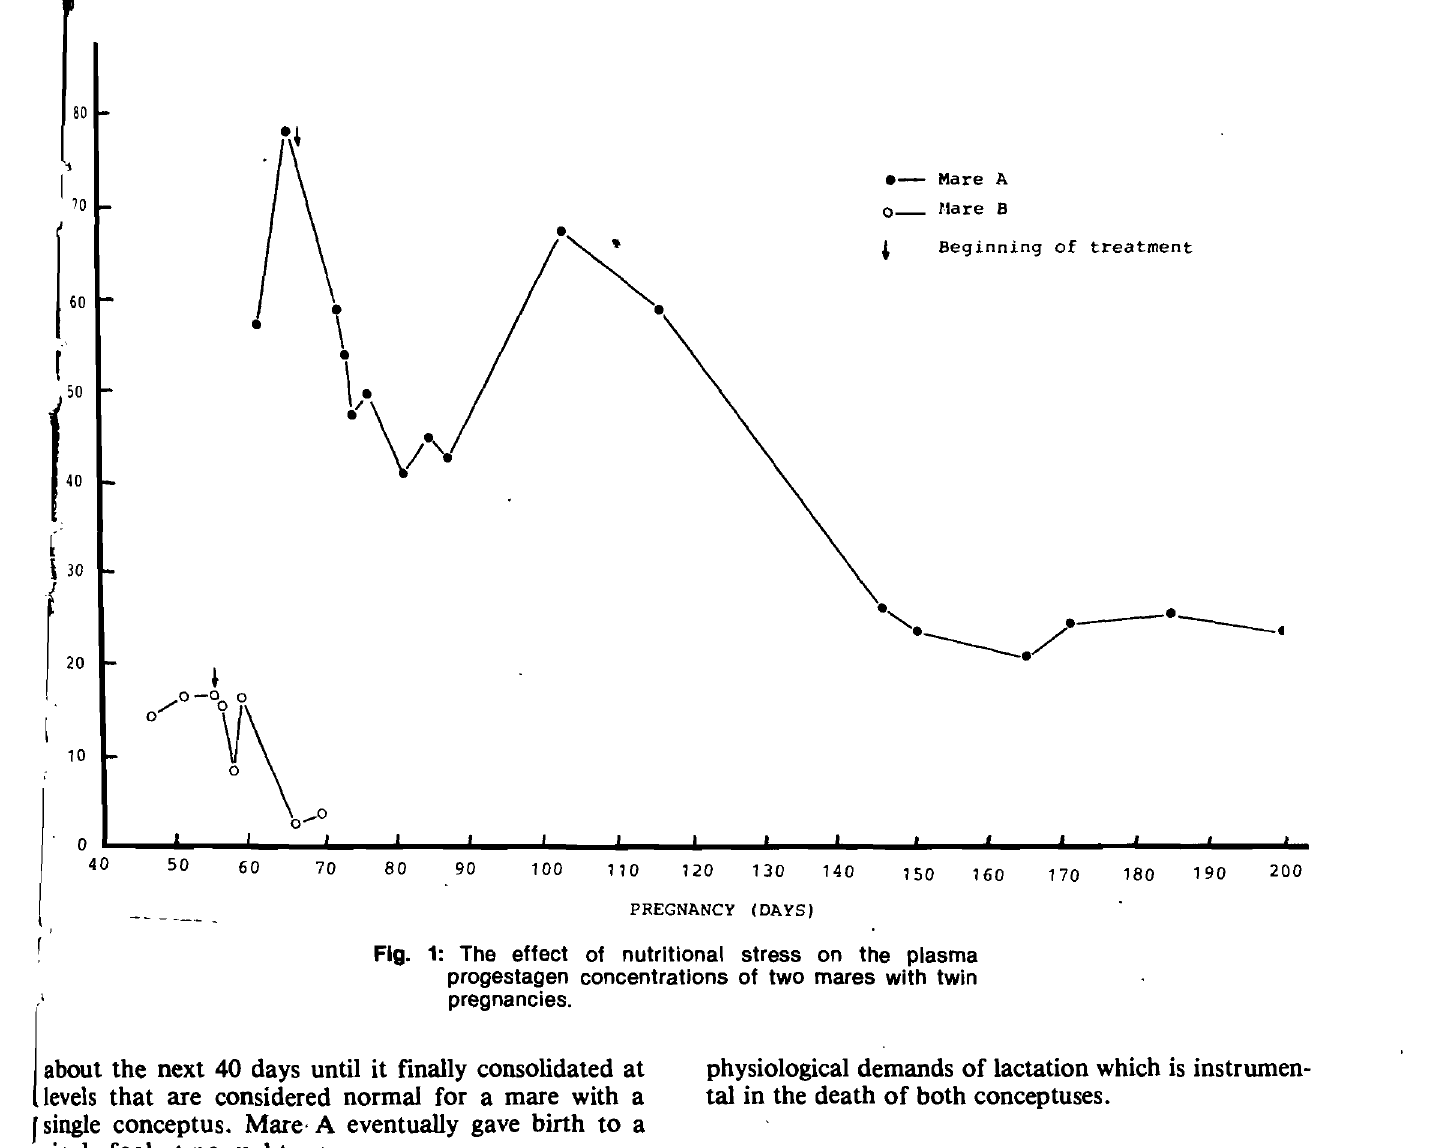
Fig. 1: The effect of nutritional stress on the plasma progestagen concentrations of two mares with twin